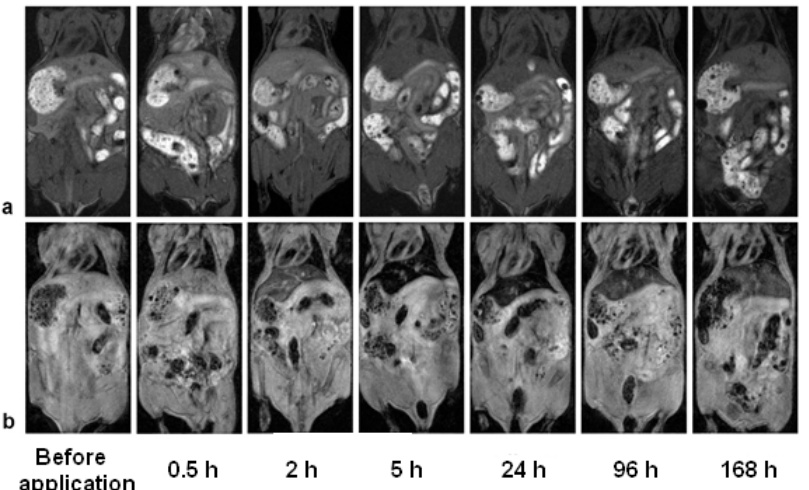
Figure 8. ( a ) T 1 - and ( b ) T 2 *-weighted MR images of the mouse before retroorbital administration of TbF 3 :Gd 3+ ,Yb 3+ ,Nd 3+ @P(DMA-AGME)-Ale nanoparticles and in several time intervals after the